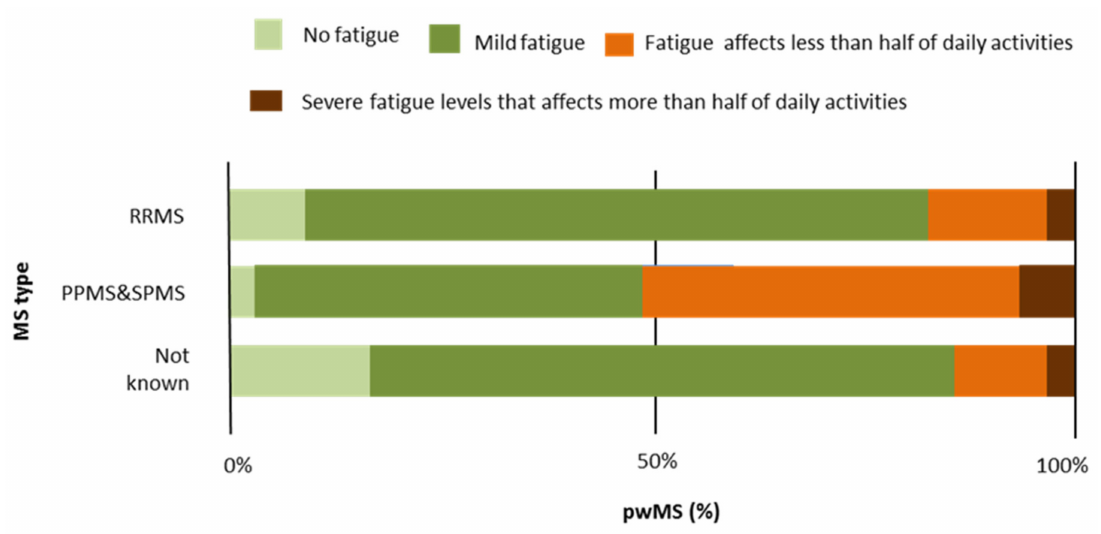
Figure 2. Average percentages of fatigue with regard to MS